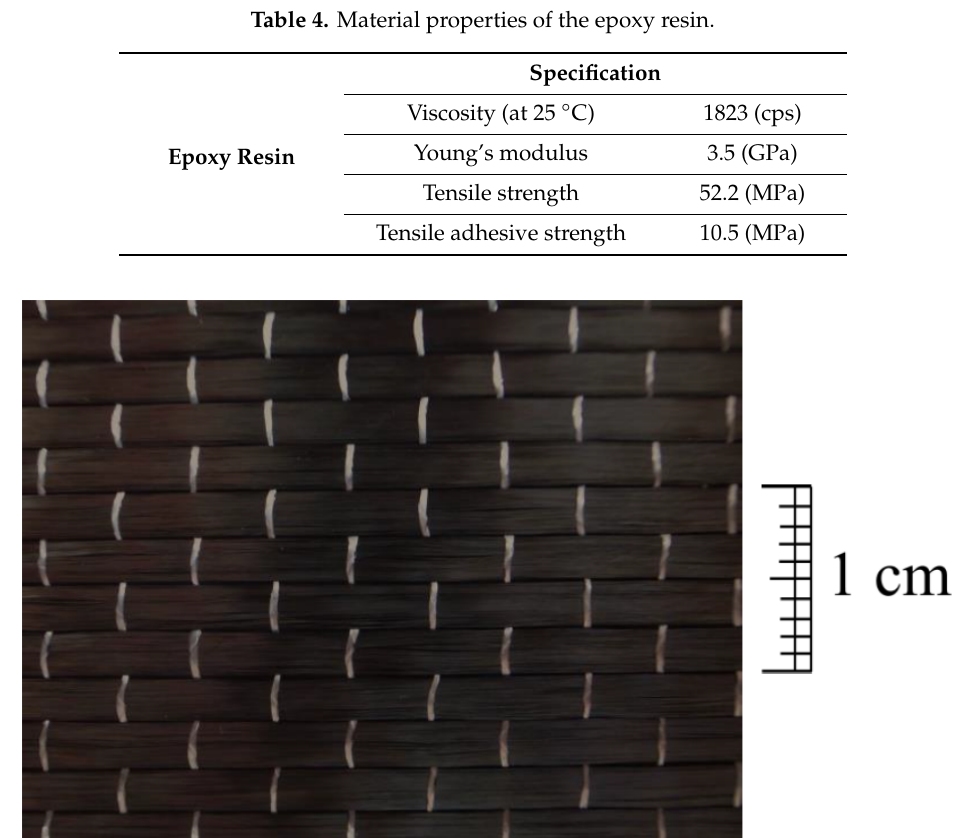
Figure 2. Carbon fiber sheet.